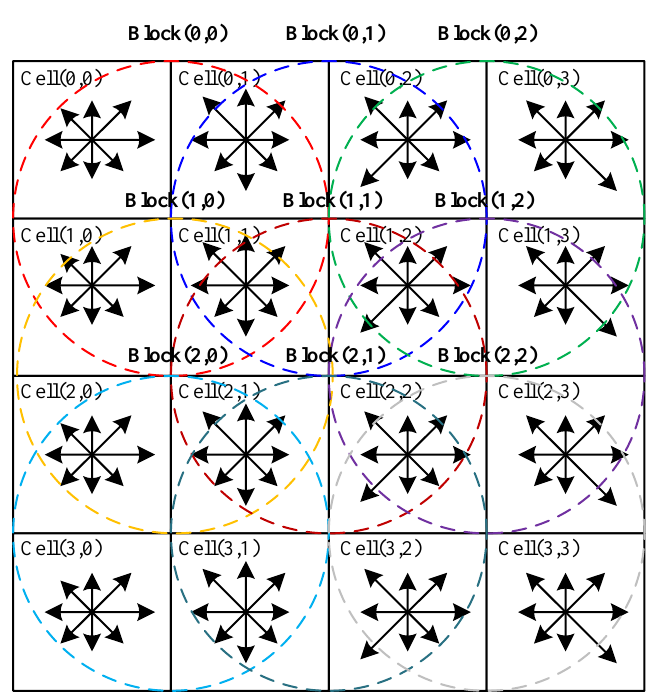
Figure 5. S-HOG eigenvalues calculated by slices and their set.